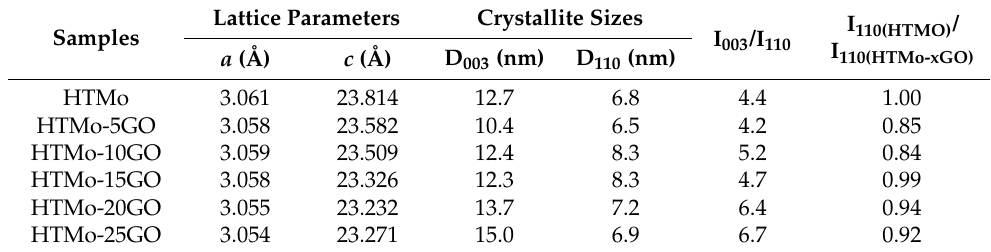
Table 3. Structural data for HTMo and HTMo-xGO